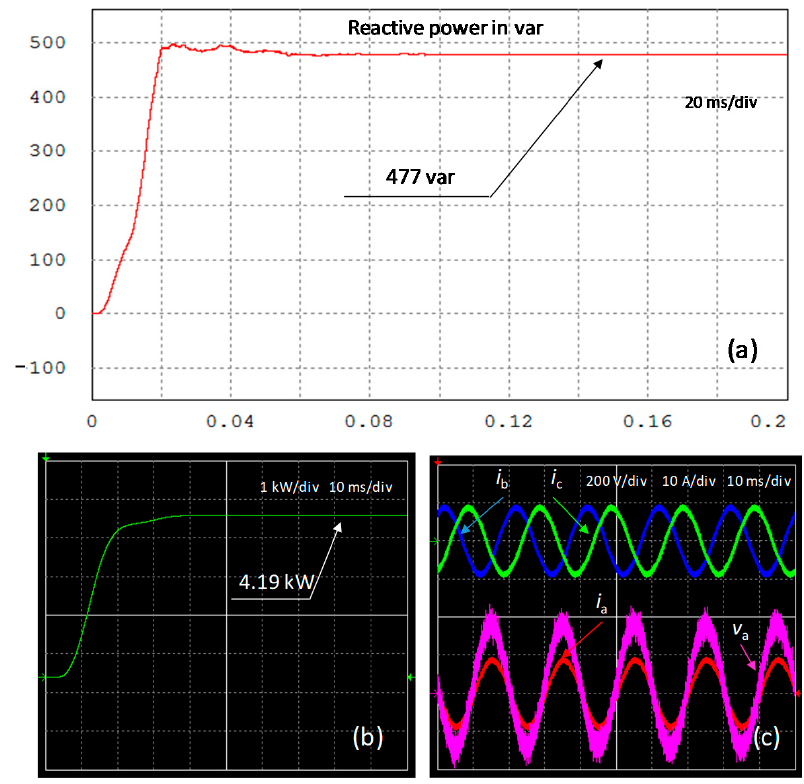
Figure 9. Registered data for reference active current I α ref = 10 A and reference reactive current I β ref = 1 A: reactive power in var ( a ); active power in W ( b ); grid currents and voltage waveforms ( c ).